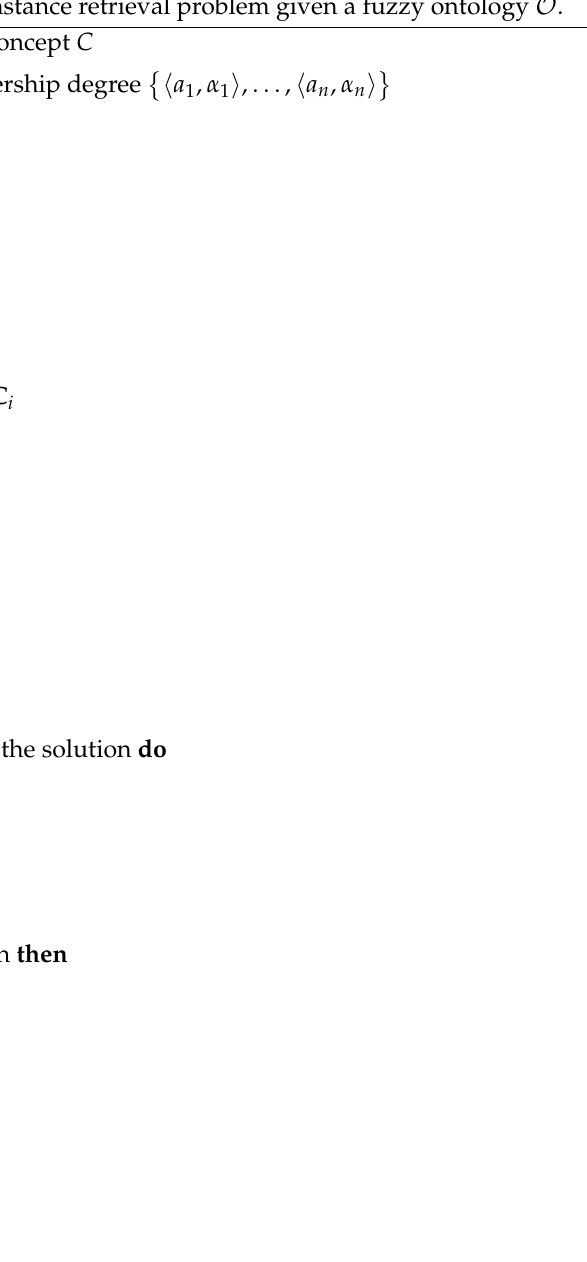
Algorithm 2 Algorithm to compute the instance retrieval problem given a fuzzy ontology O